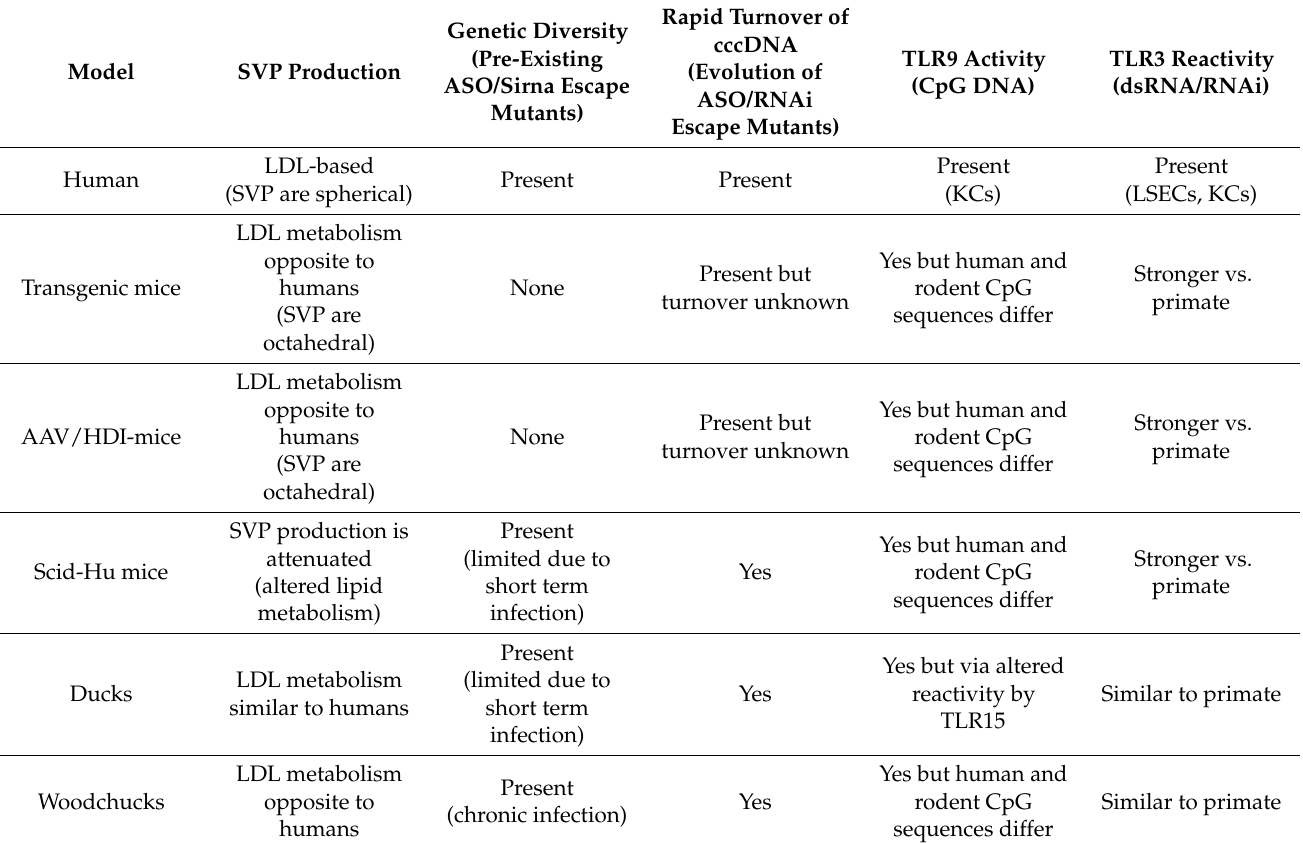
Table 1. Suitability of animal models of HBV infection for evaluating oligonucleotide-based